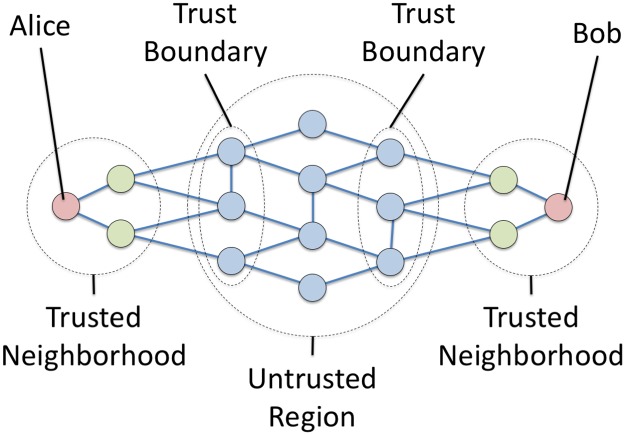
Illustration of a trusted communication network and the network properties used by the bounded trust model.Edges represent mutually trusted communication links. The sender (Alice, s) and receiver (Bob, t) trust all nodes less than the trust radius
h hops away. These nodes form their trusted neighborhoods Th(v) and Th(w). We assume that all faults occur in the remaining nodes: the untrusted region. The untrusted nodes in contact with the trusted neighborhoods for the trust boundaries Bh(v) and Bh(w), which (in the absence of central bottlenecks) determine the effective redundancy δh provided by the network. Alice and Bob can achieve the same level of attack-tolerance as if they were directly connected by δh redundant channels.